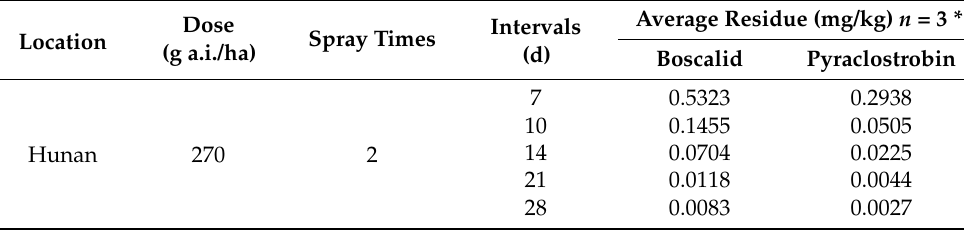
Table 3. Dissipation data of boscalid and pyraclostrobin in watermelon in Hunan province. Dose Intervals Spray Times Location (g a.i./ha)